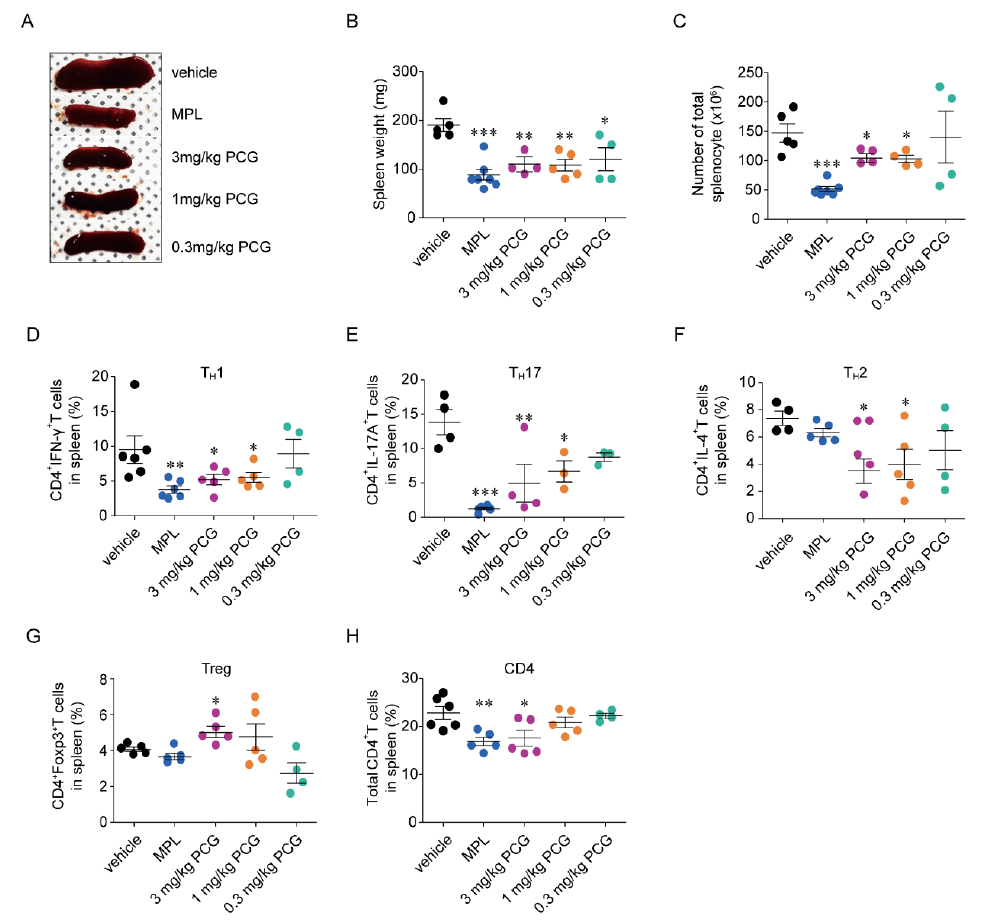
Figure 5. PCG induces a functional rebalance of splenic T cell subsets in NZB/W F1 mice. ( A